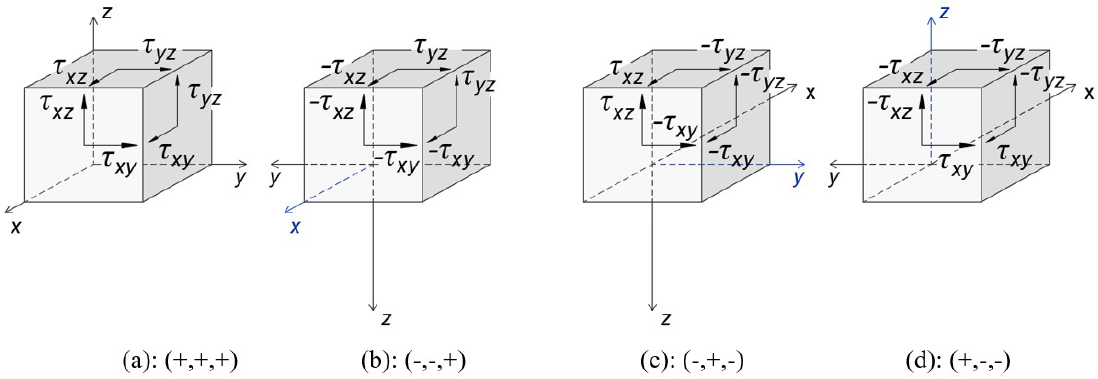
Figure 5. Positive shear stresses in Case 1